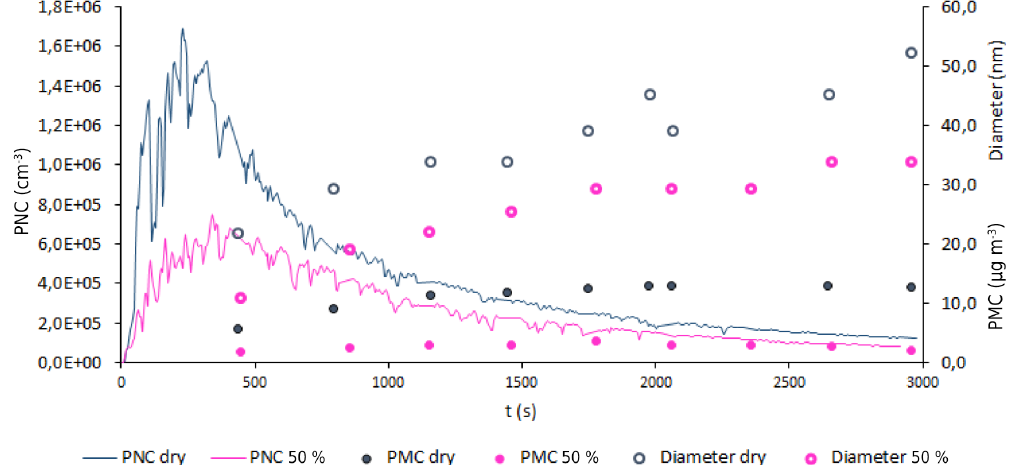
Figure 4. Effect of water vapour on PNC, on PMC and on the particle diameters’ profiles: dry conditions versus 50% RH. Both experiments were carried out with 0.5, 1.0 and 0.5ppm initial concentrations of 2,3-DHF, ozone and SO 2 , respectively.